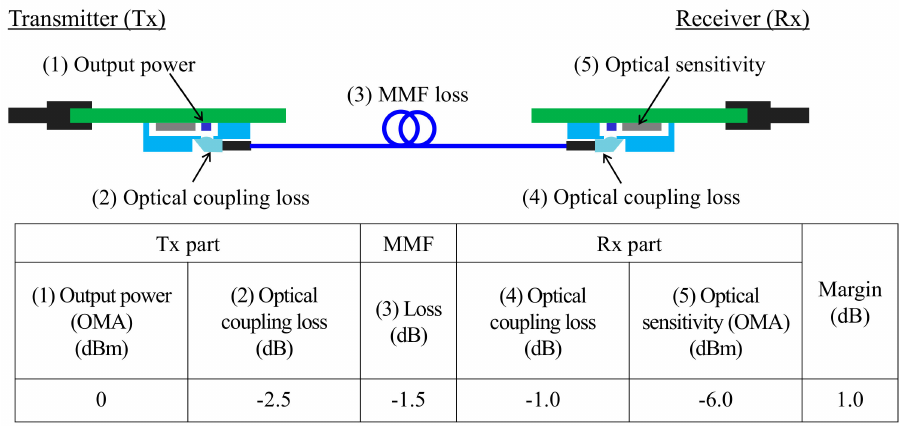
Figure 2. Loss budget of 25.78-Gbit/s MMF optical link.